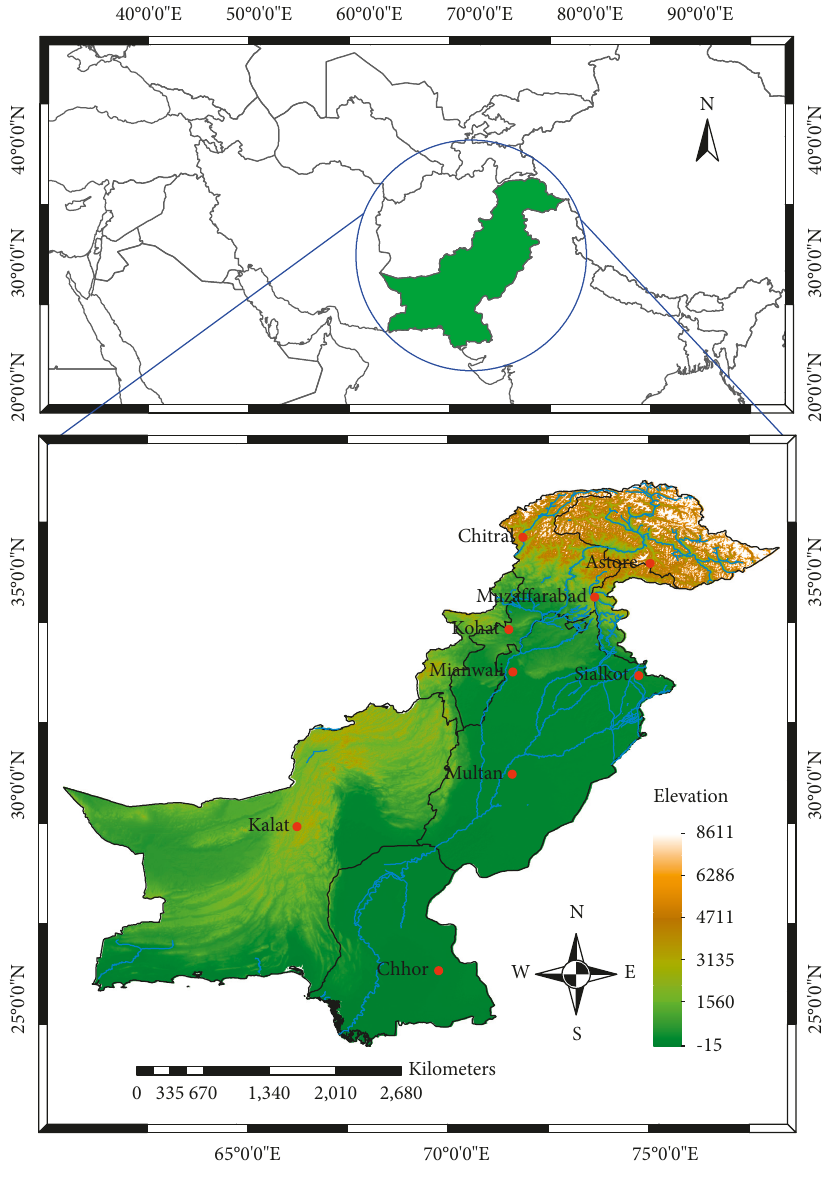
Figure 1: Topographic map of the study area and geographical distribution of meteorological stations.